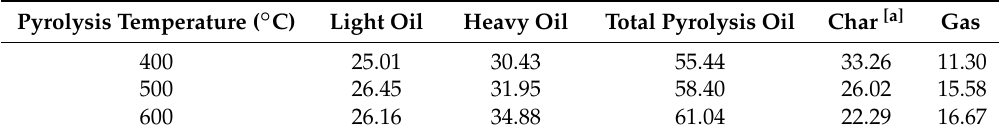
Table 4. Yields of light oil, heavy oil, char, and gas for the pyrolysis of pine residue at 400, 500, and 600 ◦ C. Pyrolysis Temperature ( ◦